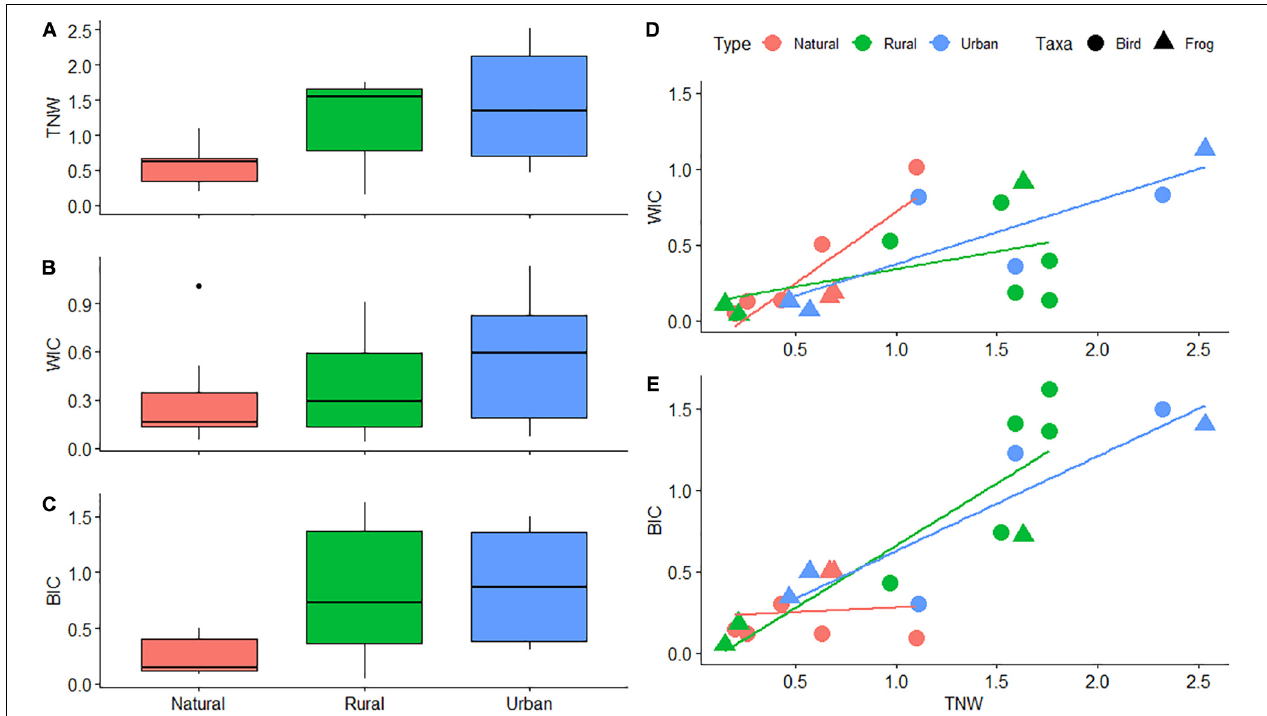
FIGURE 4 | Differences in niche components and their relationshisp across and within habitats. (A) Differences in Total (i.e., population) Niche Width (TNW; y -axis) between natural, rural and urban habitats ( x -axis). (B) Differences in the Within-Individuals niche Component (WIC; y -axis) between natural, rural and urban habitats ( x -axis). (C) Differences in the Between-Individuals niche Component (BIC; y -axis) between natural, rural and urban habitats ( x -axis). (D) Linear relationships between the Within-Individuals niche Component (WIC; y -axis) and TNW (x-axis) in natural, rural and urban habitats. (E) Linear relationships between the BIC ( y -axis) and TNW ( x -axis) in natural, rural and urban